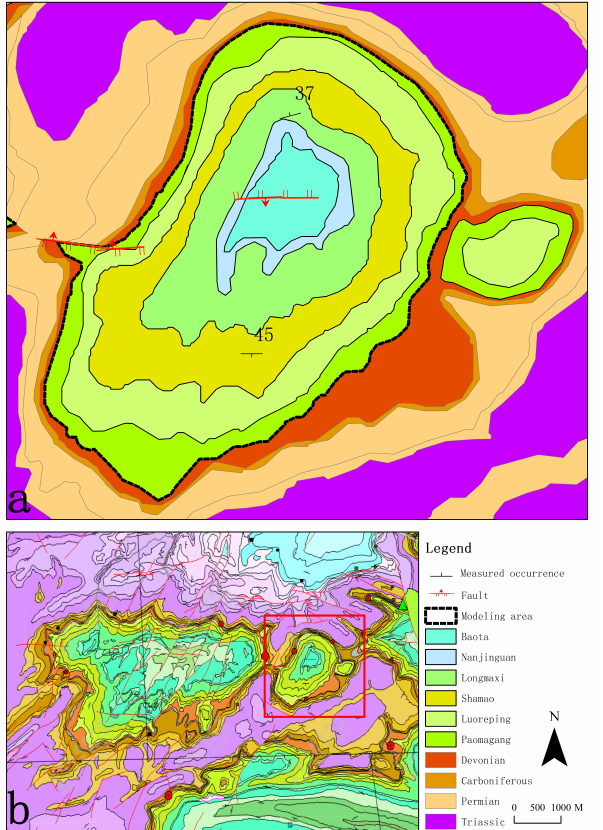
Figure 9. Wulongshan dome geological map: ( a ) Wulongshan dome structure (NGAC); ( b ) Xiang- longshan anticline structure